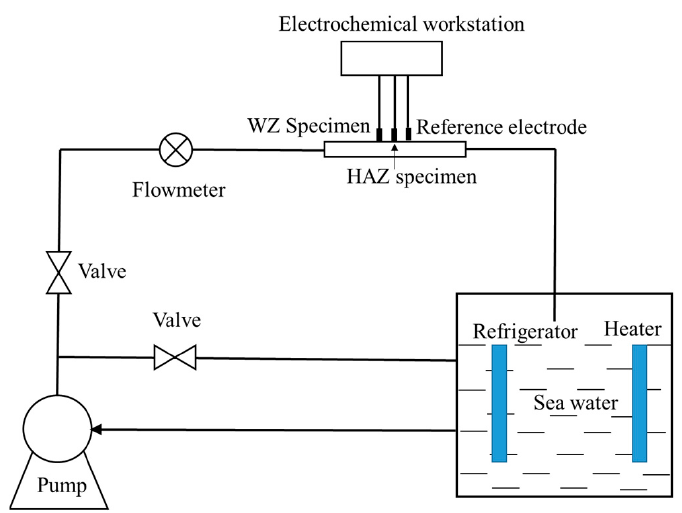
Figure 2. Schematic diagram of a device for electrochemical measurement in flowing seawater.